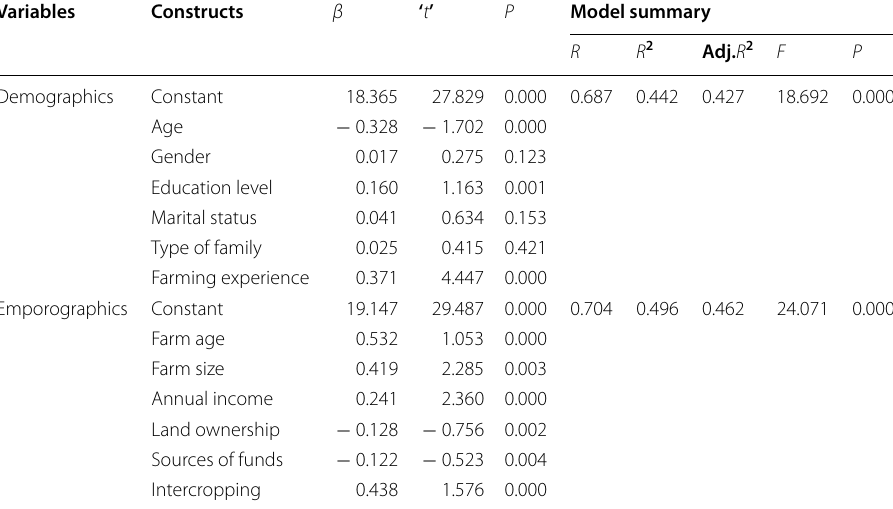
Table 7 Regression model summary